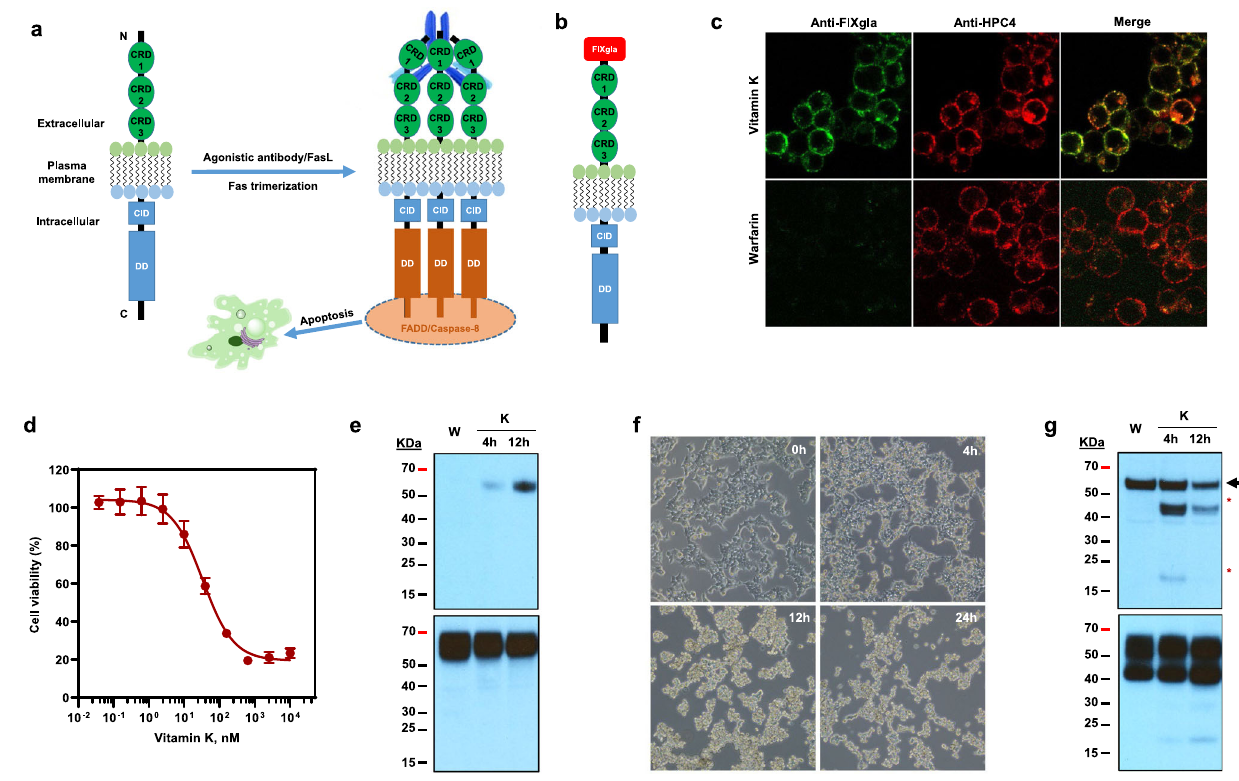
Fig. 1 | Characterization of the vitamin K-dependent apoptotic reporter cell line.a SchematicdiagramofactivationofFas-mediatedapoptosis.Fasligand(FasL) or Fas agonistic antibody activates Fas by forming a trimer and death-inducing signaling complextriggeringtheextrinsicpathwayof apoptosis.CRD cysteine-rich domain, CID calcium-inducing domain, DD death domain, FADD Fas-associated proteinwithdeathdomain.FasagonisticantibodywasindicatedasYshapeinblue on the back of the CRD domains of activated Fas. b Diagram of the chimeric reporter protein FIXgla-Fas with the Gla domain of factor IX fused to the extra- cellular N-terminus of Fas. c Immuno fl uorescence confocalmicroscopeimaging of HEK293 cells stably expressing the reporter protein FIXgla-Fas. FIXgla-Fas/HEK293 reporter cellswere incubated with 11 µ M vitamin K (top)or 5 µ M warfarin (bottom) for 12h. Cells were co-immunostained with FITC-labeled anti-carboxylated FIXgla antibody (green) and APC-labeled anti-HPC4 antibody (red). d VKD apoptosis of FIXgla-Fas/HEK293reportercells.Thereportercellswereincubatedwithincreasing